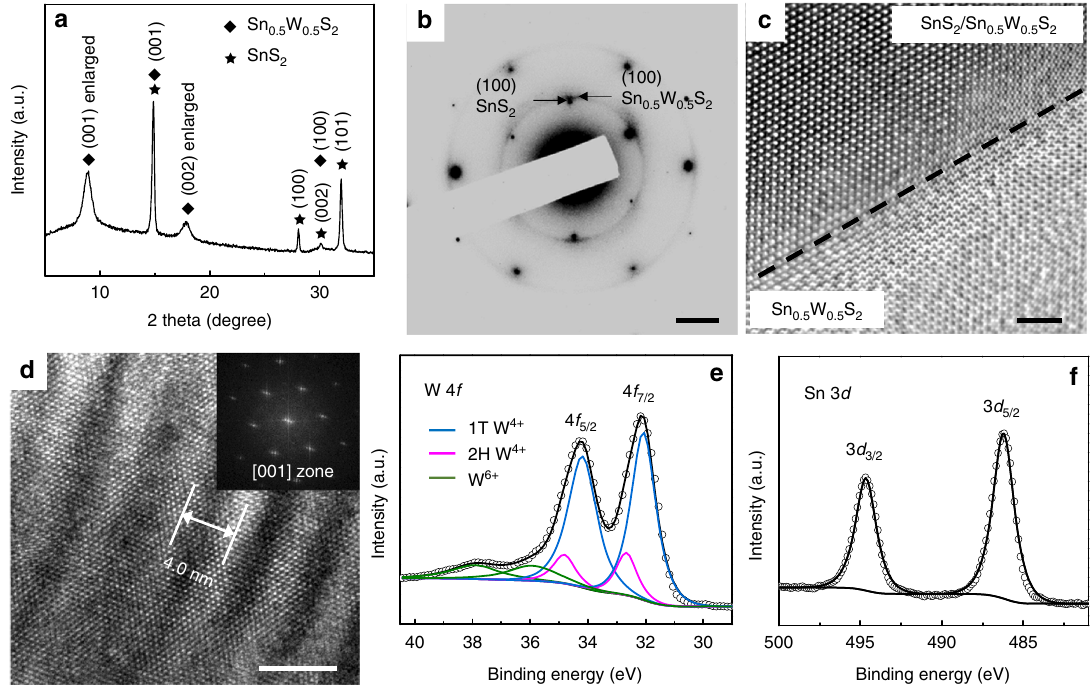
Fig. 2 Structural properties of Sn 0.5 W 0.5 S 2 /SnS 2 heterostructures. a XRD pattern of Sn 0.5 W 0.5 S 2 /SnS 2 heterostructures deposited on a glass slide. b SAED patterns of a Sn 0.5 W 0.5 S 2 /SnS 2 heterostructure along the [001] zone axis (scale bar, 2 nm − 1 ). c HRTEM image of a typical Sn 0.5 W 0.5 S 2 /SnS 2 heterostructure lying fl atly on a copper grid (scale bar, 2 nm). d A Moiré pattern with a periodicity of 4.0 nm was observed (scale bar, 5 nm), whose fast Fourier transform (FFT) diffraction pattern is shown as the inset. XPS ( e ) W 4 f and f Sn 3 d spectra of as-prepared Sn 0.5 W 0.5 S 2 /SnS 2